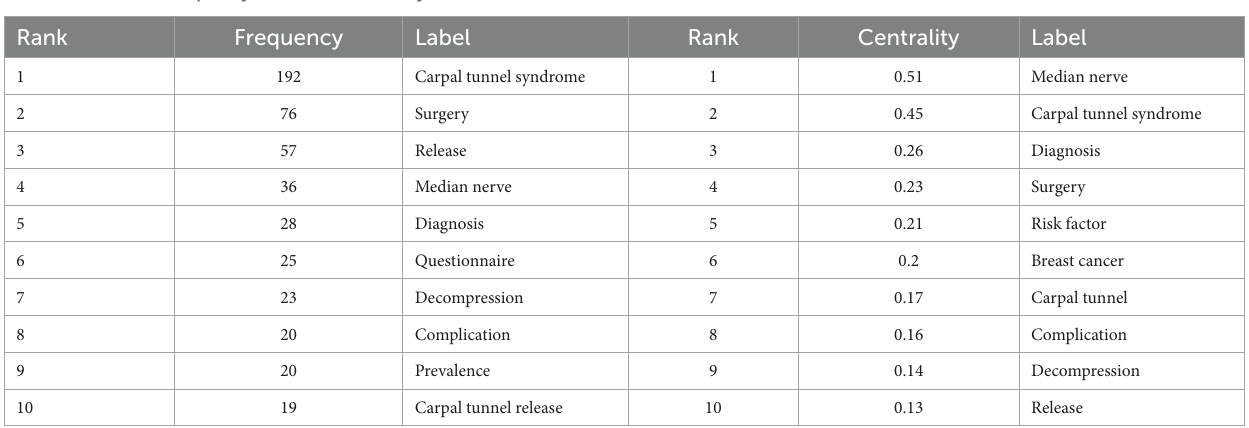
TABLE 2 TOP-10 of frequency, TOP-10 of